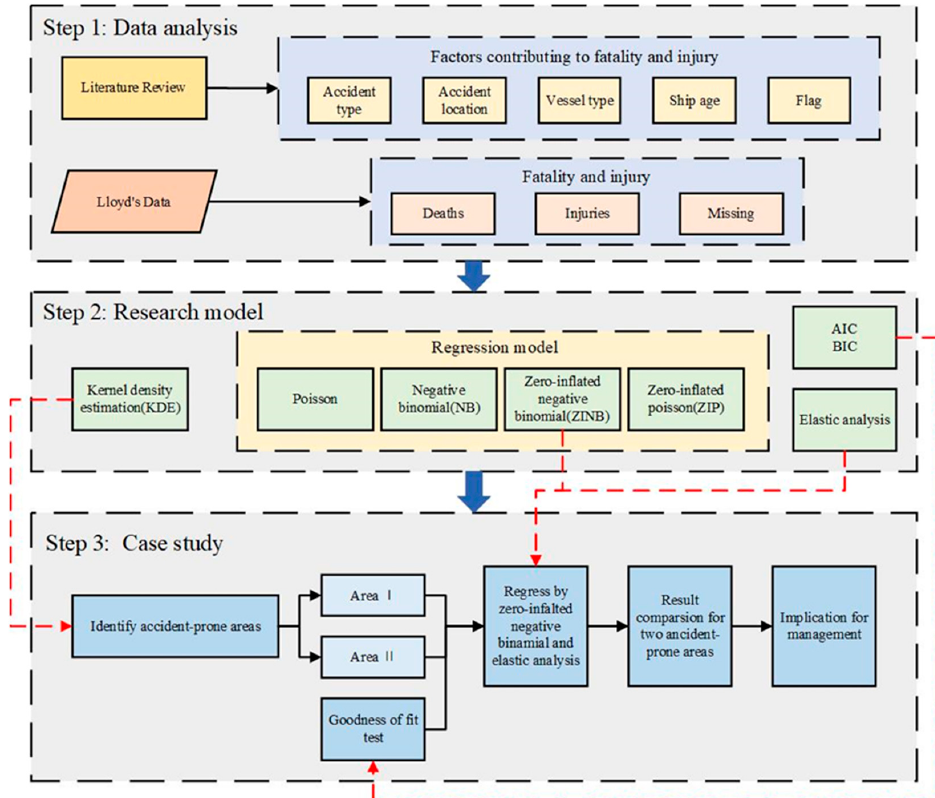
Figure 2. Model construction logic diagram.